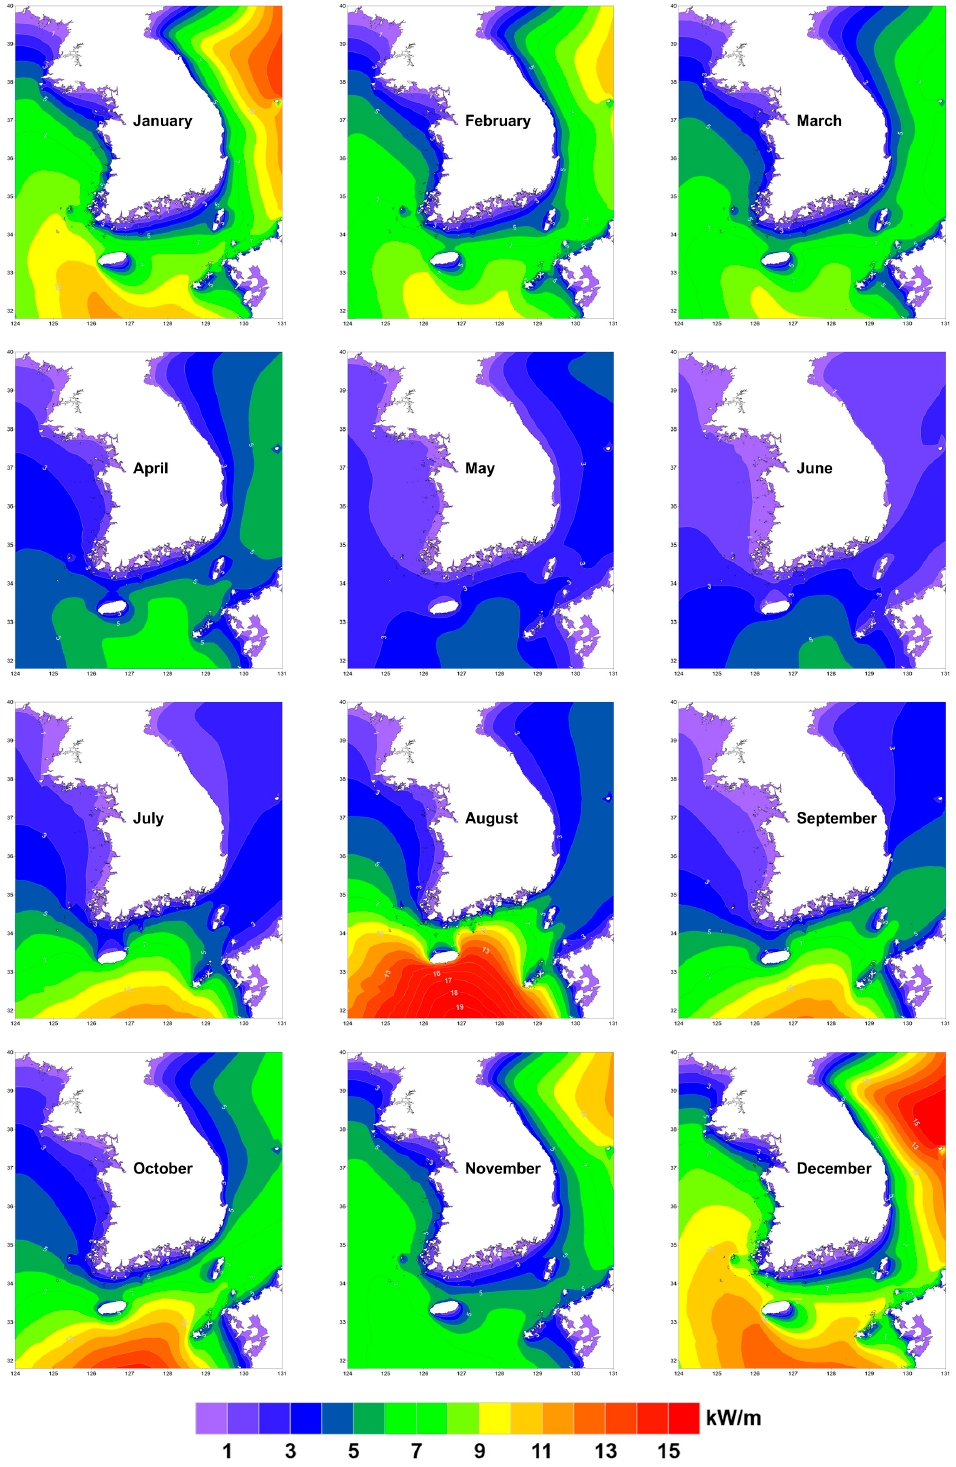
Figure 12. Monthly wave power around the Korean Peninsula over 2007–2018.